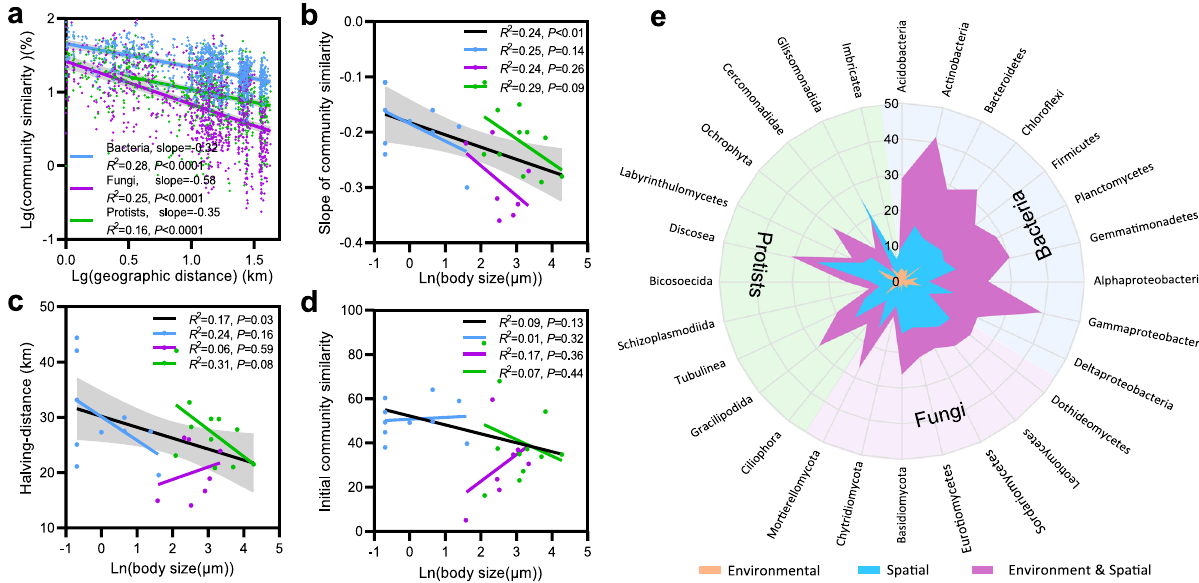
Fig. 3 Distance-decay relationship and variation partitioning analysis of soil microbiomes across distinct organism body sizes. a Distance-decay relationship regressions based on log-transformed Bray-Curtis similarities between pairs of communities and log-transformed geographic distances between sampling sites. Linear correlations between the slopes ( b ), halving-distance ( c ), and initial community similarity ( d ) of the distance-decay relationships and the logarithm of body sizes for the 28 organism groups, including 10 bacterial groups, 7 fungal groups, and 11 protistan groups. The statistics are for the regression of all data points. Lines represent the least squares regression fi ts and shaded areas represent the 95% con fi dence intervals. We applied one-sided F test and two-sided t test, and the calculated P values as shown. e Variation in composition of each organism group partitioned into pure environmental factors, spatial factors, and combined